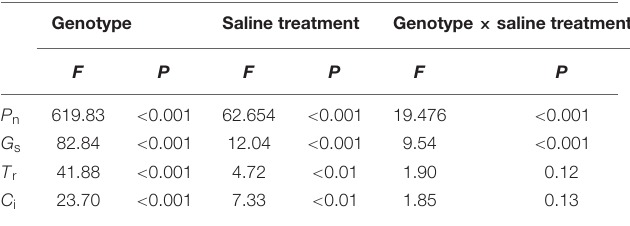
TABLE 1 | Two-way ANOVA examining the effects of genotype, saline treatment and their interaction (genotype × saline treatment) on the photosynthetic gas exchange parameters of leaves from the three Physocarpus amurensis sample